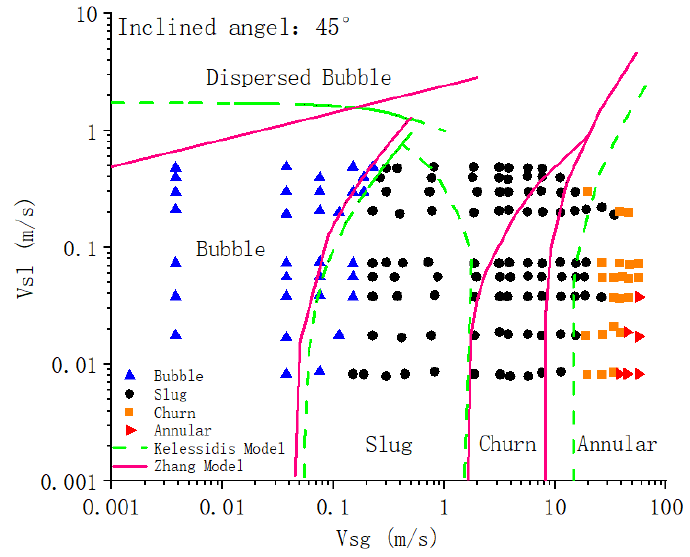
Figure 8. Comparison between flow pattern diagrams of different models and experiments with 45° inclination angle.